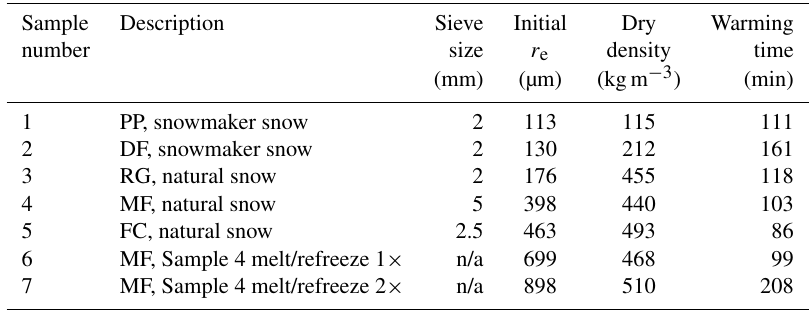
Table 1. Laboratory snow samples (reported r e is from scaled band area method).